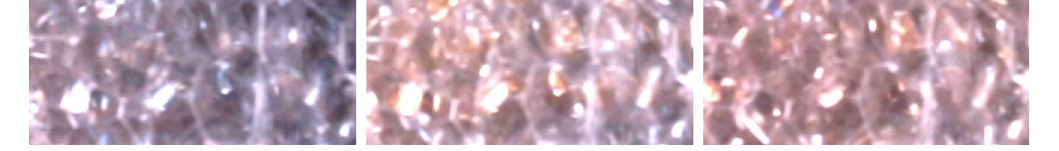
FIG. 6. Side view images (diffused reflected light) of the foam under 0 (left), 200 (middle) and 400 V (right) with a color camera ( L ¼ 24 mm, R ¼ 3 mm, image height is 20